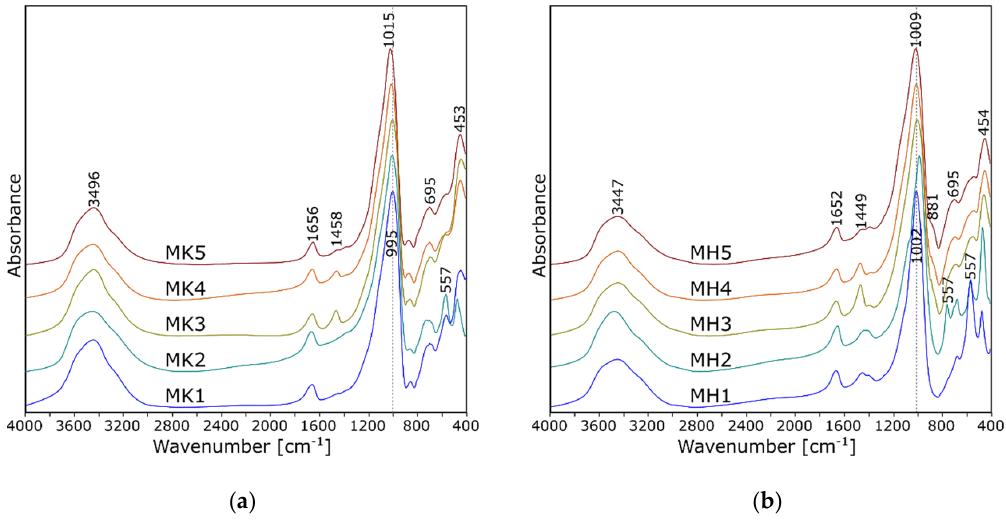
Figure 6. The MIR spectra of alkali-activated: ( a ) metakaolin; ( b ) metahalloysite.